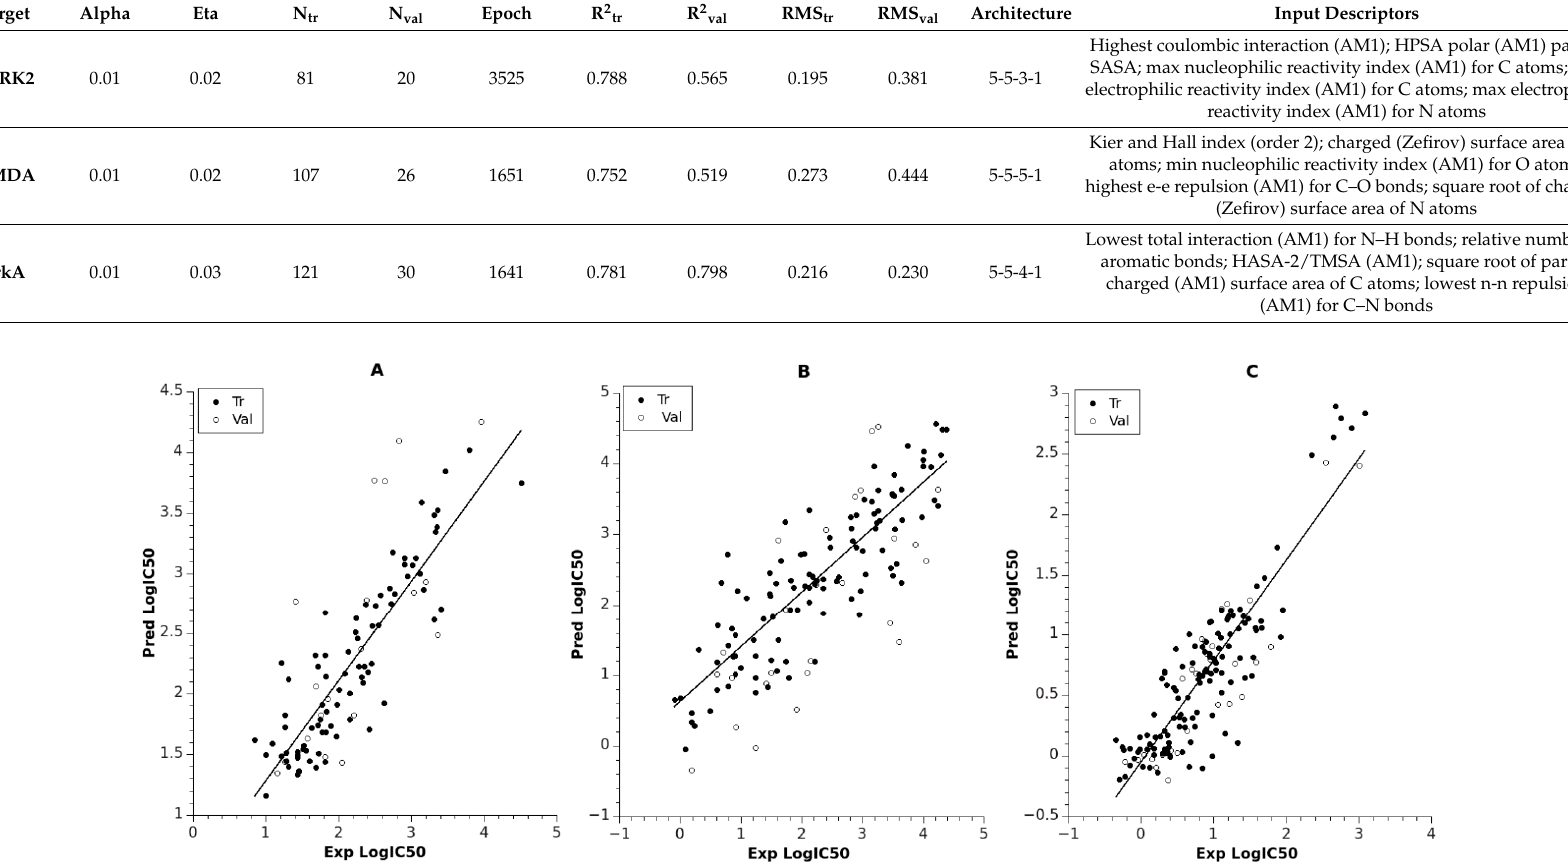
Figure 1. Predicted vs. experimental logIC 50 for training and validation sets: ( A ) ANN model for LRRK2; ( B ) ANN model for NMDA; ( C ) ANN model for TrkA. Trend lines used for training data.